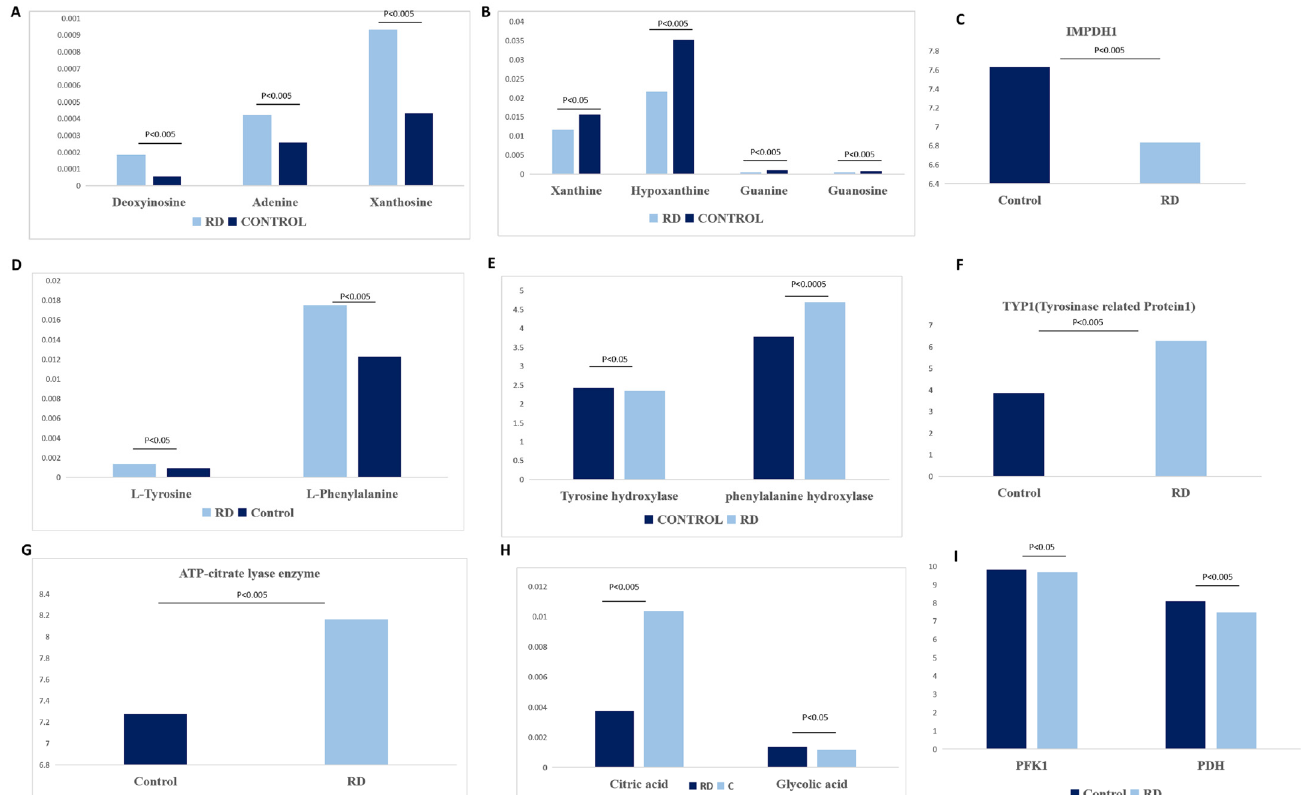
Figure 7. The alternations of main metabolomics and related genes of metabolomics in the pathway. ( A , B ) The changes of purine and pyrimidine metabolism. ( C ) Gene change of IMPDH1 after RD. ( D ) The changes of phenylalanine, tyrosine, and tryptophan biosynthesis. ( E , F ) The changes of genes in tyrosine hydroxylase, phenylalanine hydroxylase, and tyrosinase-related protein1 after RD. ( G ) Gene change of ATP-citrate lyase enzyme after RD. ( H ) The changes of glycosylate and dicarboxylate metabolites after RD. ( I ) Gene alternations of phosphofructokinase 1 (PFK1) and pyruvate dehydrogenase 1 (PDH1) after RD.